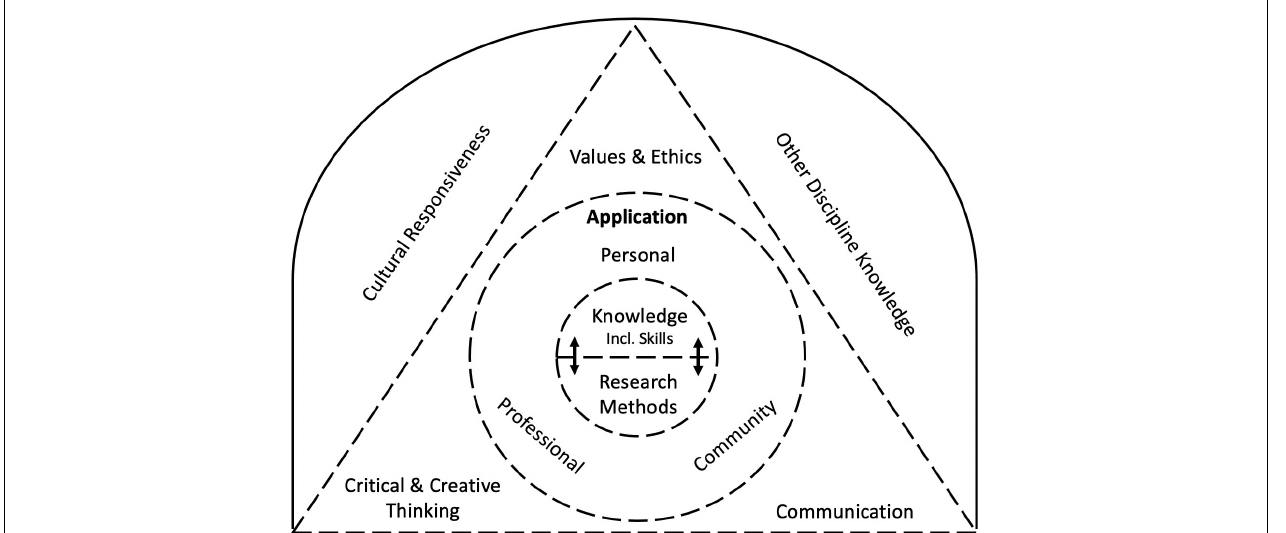
FIGURE 1 | Undergraduate psychology education graduate capabilities and interconnectivities. The Core of the discipline of psychology, Knowledge, Research Methods and Application (of Knowledge to Personal, Professional and Community Domains, with the latter including Local, National, and International), is represented by the two circles. The Generic capabilities of Values and Ethics, Critical Thinking, and Communication are not only expected graduate capabilities of most undergraduate students, but they influence and are influenced by Core discipline capabilities. Indeed, the dashed lines indicate two-way influence across near and far figurative boundaries (e.g., Values influence Methods that influence Knowledge). This model builds upon and extends Figure 6 of Cranney et al. (2012). Note that Other Discipline Knowledge interacts with the Psychology Core and Generic capabilities. Cultural Responsiveness infuses all other capabilities. Finally, the scale of the figure does not depict the recommended extent of focus in the curriculum (e.g., one would expect a significant focus on research